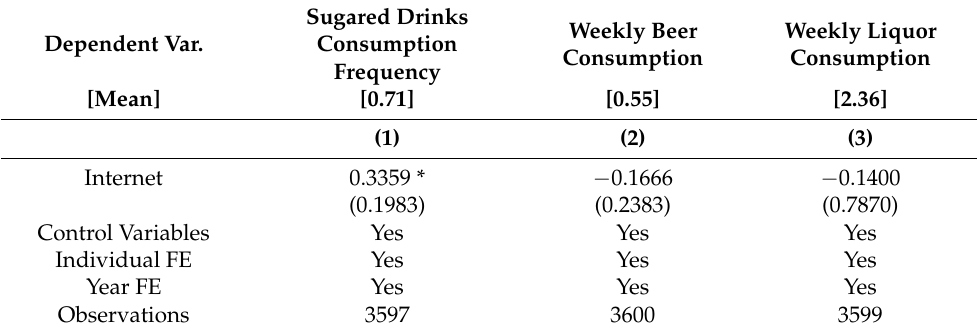
Table 8. Impact of Internet use on other health-related food intake: sugared drinks and alcohol. Sugared Dependent Var.